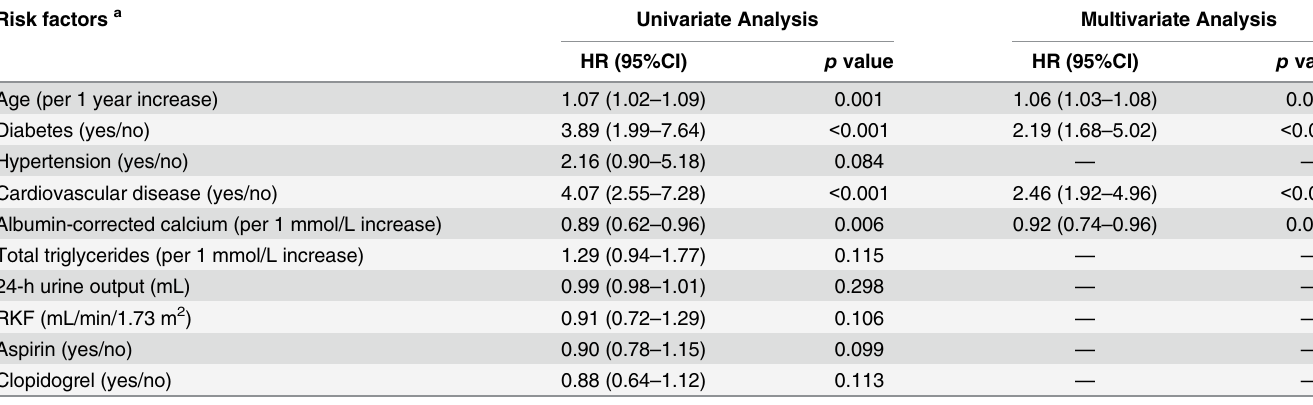
Table 6. Risk factors for stroke in hemodialysis patients.